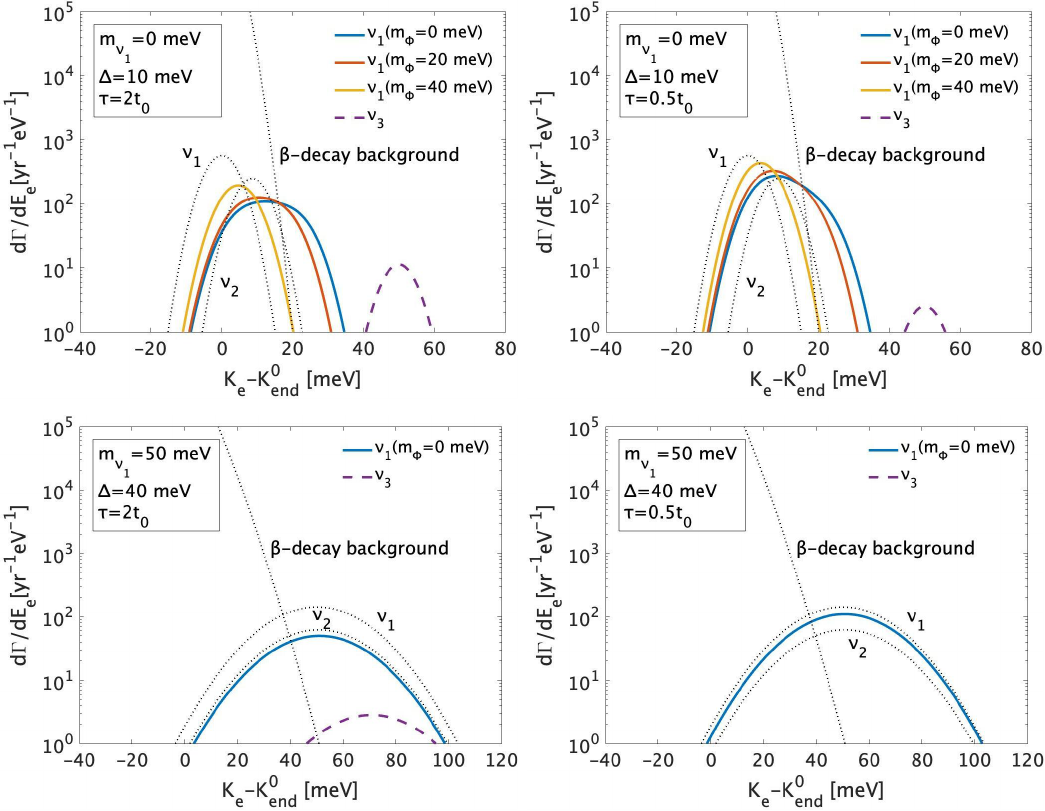
Figure 3 . The expected spectra from the 2-body decays, ν 3 → ν 1 φ , in the neutrino capture on 100 g of tritium for the NO case. We set ( m ∆ , τ ) = (0 meV , 10 meV , 2 t ) (top left ν 1 , ν 3 0 panel), (0 meV , 10 meV , 0 . 5 t ) (top right panel), (50 meV , 40 meV , 2 t ) (bottom left panel) and 0 0 (50 meV , 40 meV , 0 . 5 t ) (bottom right panel) with several values of m . Blue, red and yellow lines 0 φ denote the spectra for ν produced by the decays of ν for m = 0 , 20 , 40 meV , respectively. A 1 3 φ purple dashed line denotes the spectrum for ν produced in the early universe but suppressed by 3 the decays of ν . Black dotted lines denote the contributions of the spectra for ν and ν produced 3 1 2 in the early universe and β -decay background. Note that the actual spectrum is a superposition of these spectra, and only m . 20 meV is kinematically allowed for m = 50 meV φ ν 1